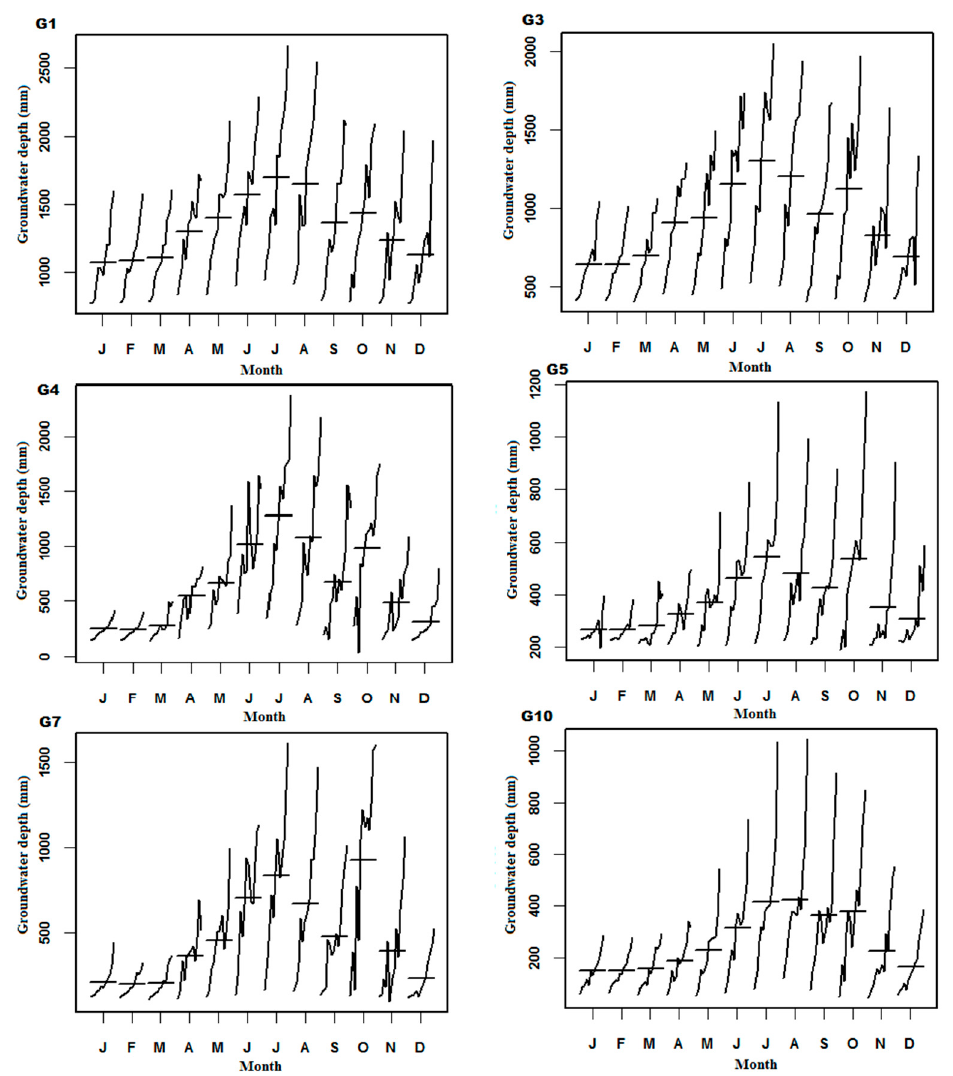
Figure 6. Seasonal cycle subseries plot of the monthly depth of the piezometric groundwater level in six sites from 2002 to 2014. Horizontal lines display the overall mean value for each month in the thirteen-year period.